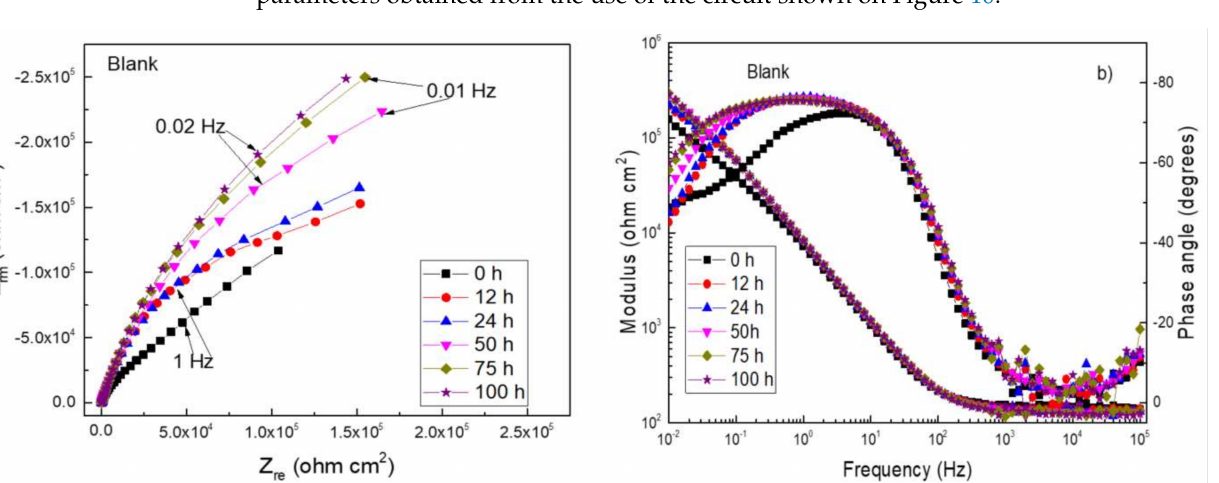
Figure 7. EIS data in ( a ) Nyquist and ( b ) Bode diagrams for untreated Ti6Al4V alloy corroded in artificial saliva solution after different exposure times.